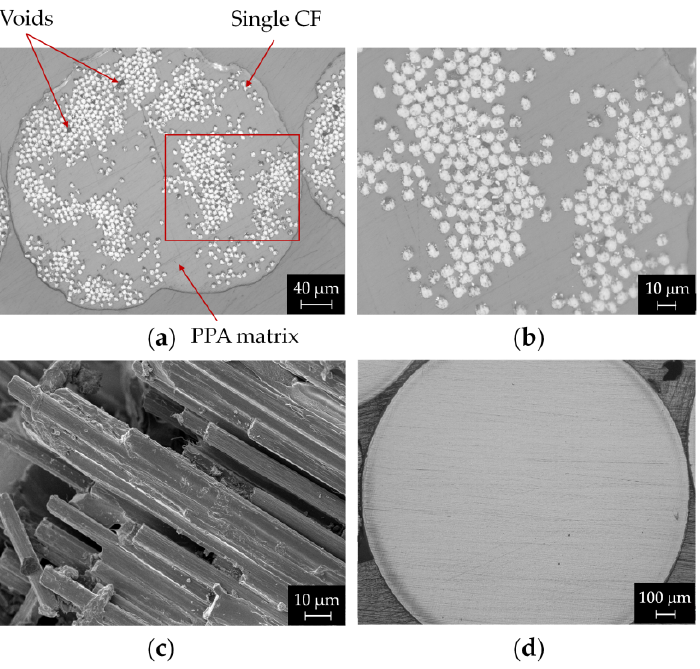
Figure 4. Optical images of polished cross-sections of ( a ) CCF filament and ( b ) magnified view of a high fibers concentration region of the CCF filament; ( c ) FESEM micrograph of CCF tow cryo-fractured surface and ( d ) cross section of PA as-received filament. Table 5. Morphological properties obtained from image analysis of PA and CCF filament’s optical micrographs and calculated fibers number and volume fraction of a local region of the CCF tow with high fiber content (marked in red on Figure 4a). The filament diameters stated by MarkForged ® are reported in bracket.